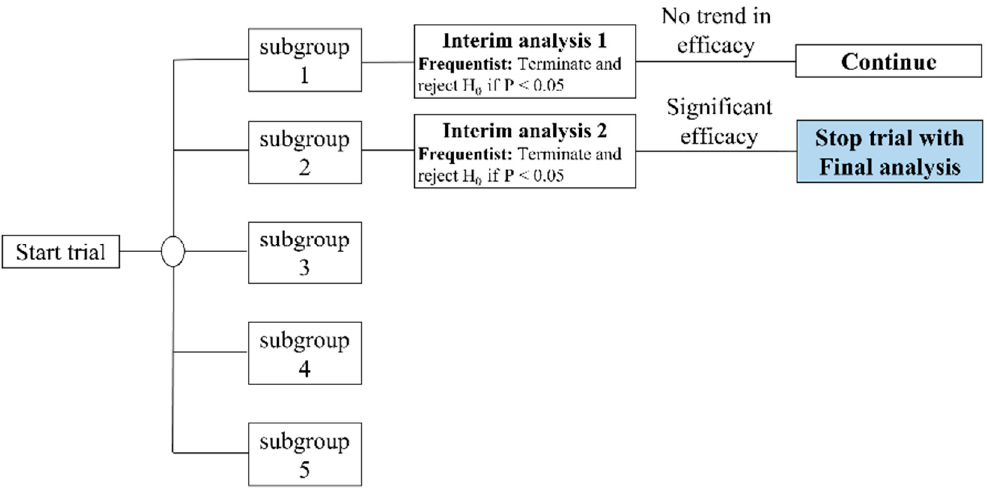
Figure 3. Flow chart of the adaptive study design with an interim analysis.